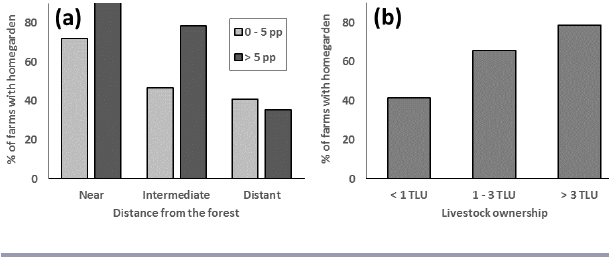
changed with increasing distance from the forest. Closer to the forest, households used significantly more fuelwood from the mostly from the farms in the intermediate zone, and mostly from Munesa Forest in the near zone (Fig. 4a). Fig. 4 . (a) Harvesting of firewood, (b) cattle grazing in Munesa Forest, and (c) section of Munesa Forest showing signs of degradation.